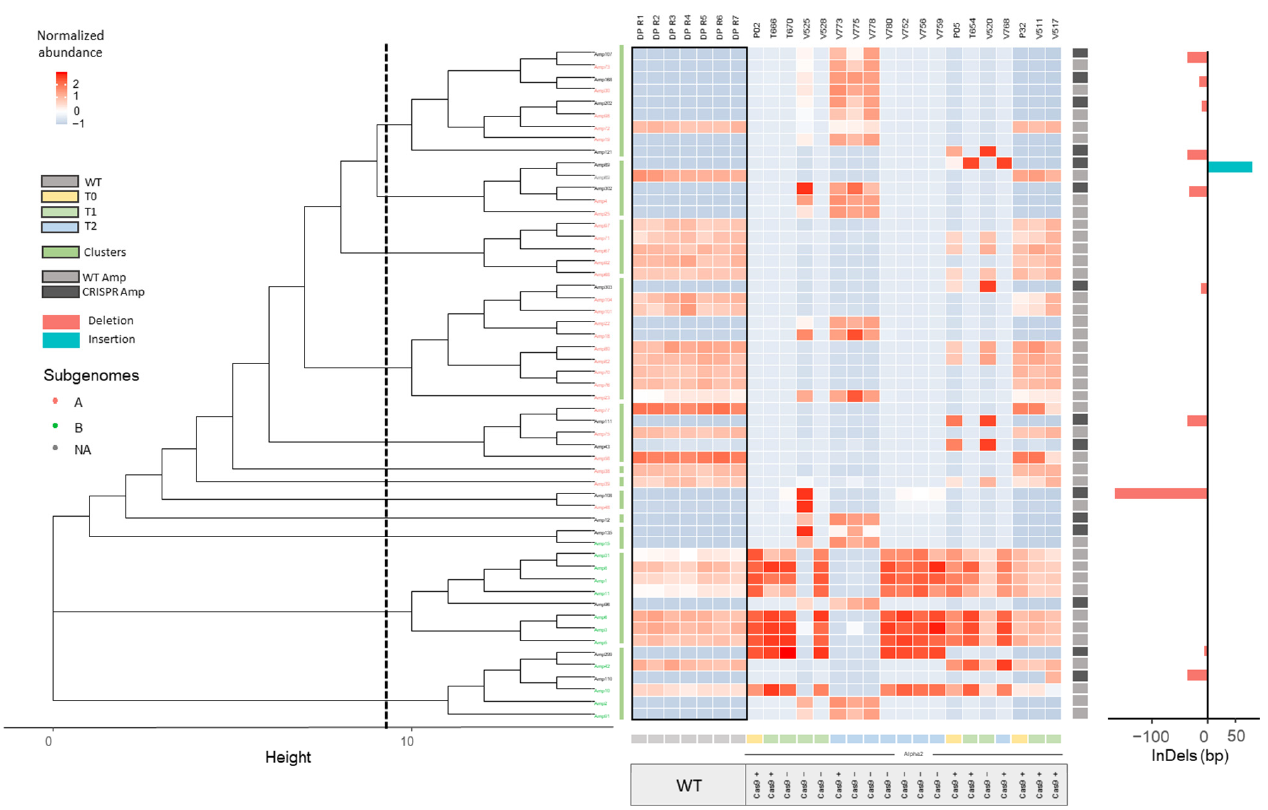
Figure 3. Dendrogram of Amps presented in lines with DP background, and their TMM normalized abundances represented as a min-max scaling heatmap. CRISPR Amps (only present in CRISPR lines) are represented in dark grey squares while WT Amps are represented as light grey squares. Clusters of Amps (green bars) were established according to the dendrogram ( left ) and were aligned through MUSCLE manually to detect the InDels size in CRISPR Amps ( right ). Relationship between lines (T0, T1, T2) and the absence or presence of Cas9 is also depicted per each line. Only Amps present in at least one line with a frequency higher than 0.3% per line were considered for the analysis. WT: wild type. Amps: unique denoised amplicons. NA: Amps not assigned to a subgenome.